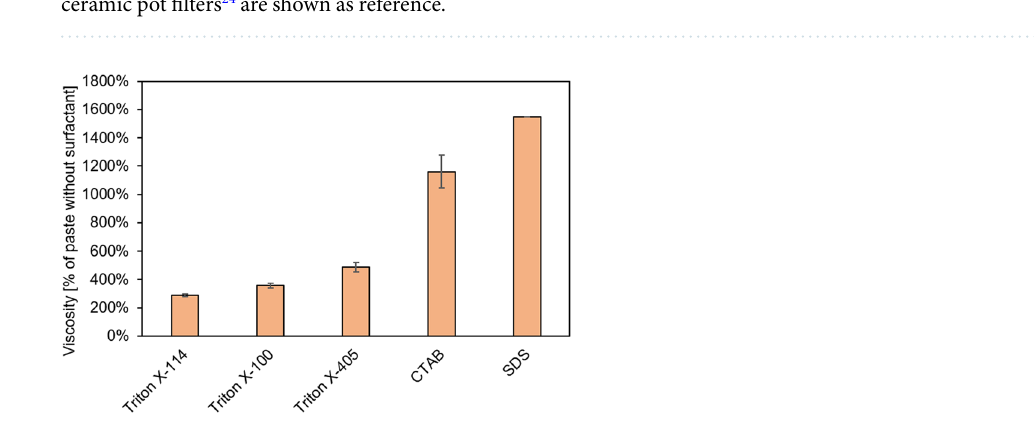
Figure 5. Water permeability coefficients of the filter samples. Values for sand, silty sand, and conventional ceramic pot filters 24 are shown as reference.